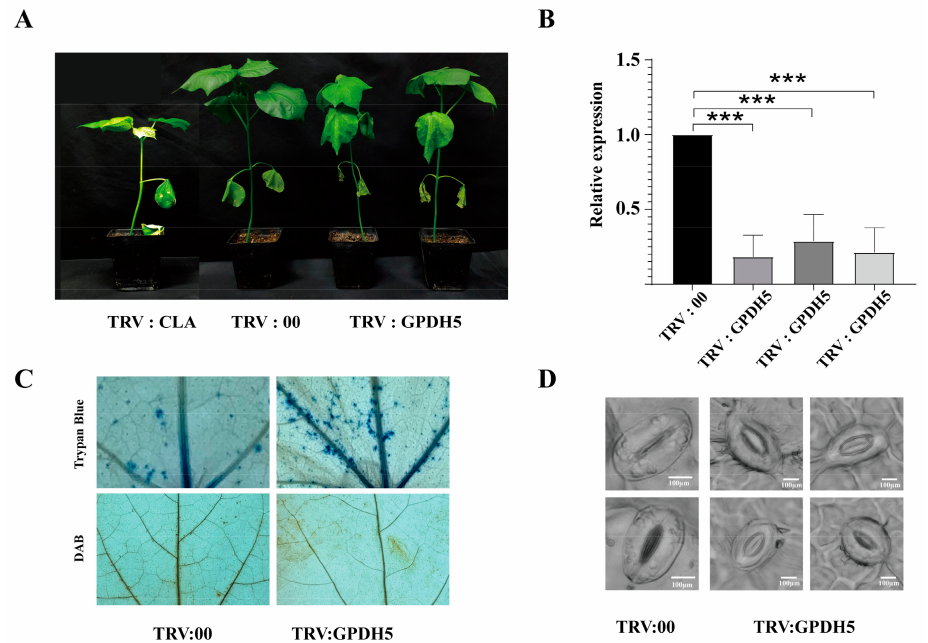
Figure 9. Functional verification of GPDH5 under drought stress. ( A ) Whole plant phenotypes of gene silenced plants. A plant with CLA -silencing, negative control plant and two plants with GhGPDH5 -silencing are shown from left to right. ( B ) Relative expression levels in silenced and TRV:00 plants. Data analysis was performed using one-way ANOVA by GraphPad Prisim 8, *** represents the extremely significant difference between negative control and experimental plants. The error bars show the standard deviation of three technical replicates ( C ) TRV:00 and TRV: GPDH5 after DAB and trypan blue staining. ( D ) Comparison of stomatal apertures between TRV:00 and silenced plants. Microscope magnification is